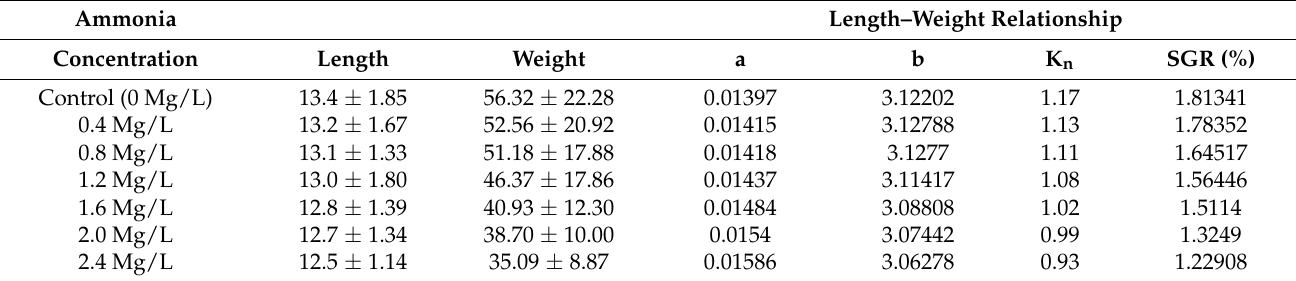
Table 2. Mean length and weight relative condition factors and specific growth rates for Nile tilapia subjected to ammonia treatment.